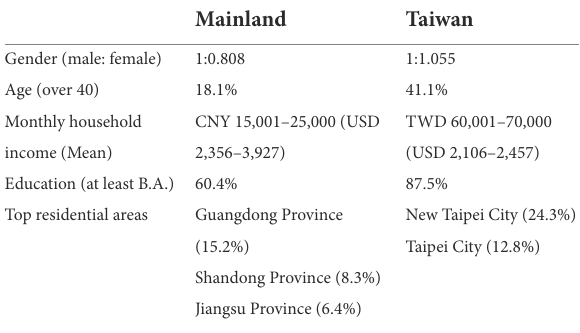
TABLE 1 Descriptive results in two Chinese